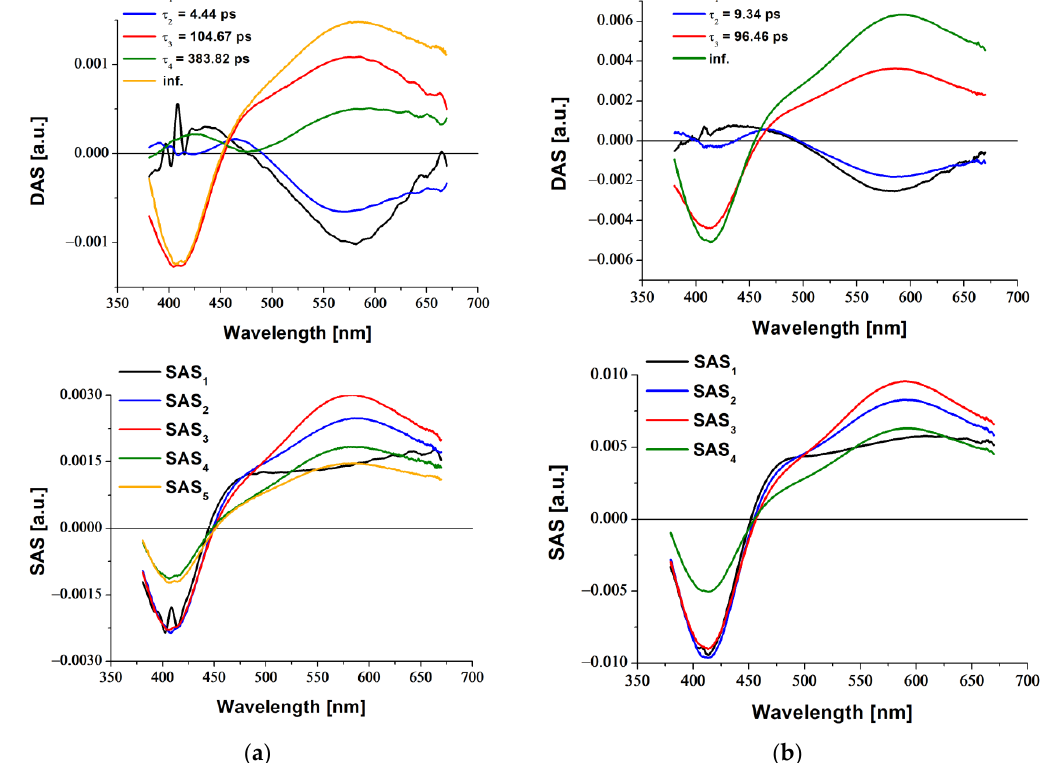
Figure 9. Decay associated spectra (DAS i ) with corresponding time constants (t i ) along with species associated spectra (SAS i ) for complexes 1 ( a ) and 2 ( b ) in acetonitrile.